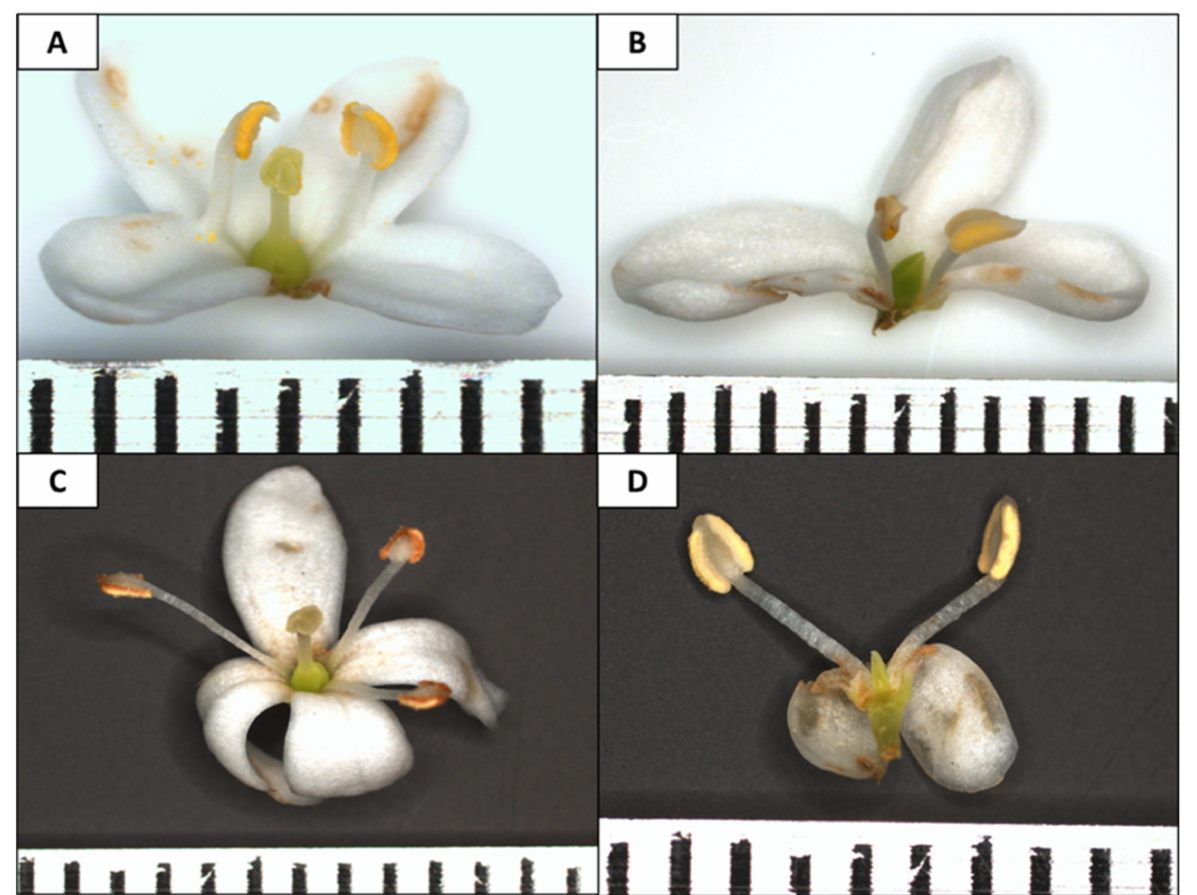
Figure 1. Flower of Osmanthus armatus ‘Longwood’—perfect flower ( A ), O. fortunei unnamed seedling—male-only flower ( B ), O. heterophyllus ‘Purpureus’—perfect flower ( C ), and O. heterophyllus ‘Kaori Hime’—male-only flower ( D ). Petals were removed from ( A , B , D ) to fully expose pistils ( A , C ) or pistillodes ( B , D ). Flowers were photographed between 11 November 2017 and 9 January